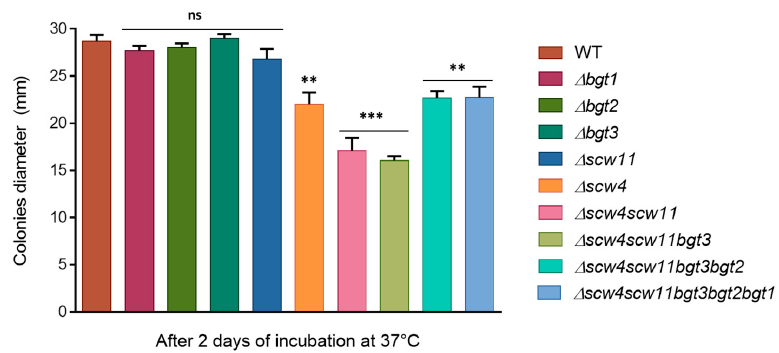
Figure 5. Growth kinetics of the parental strain and the GH17 mutants on RPMI agar medium at 37 °C. The diameter of the colonies was measured after 48 h. Values are mean ± SD of three independent determinations. WT, parental strain.